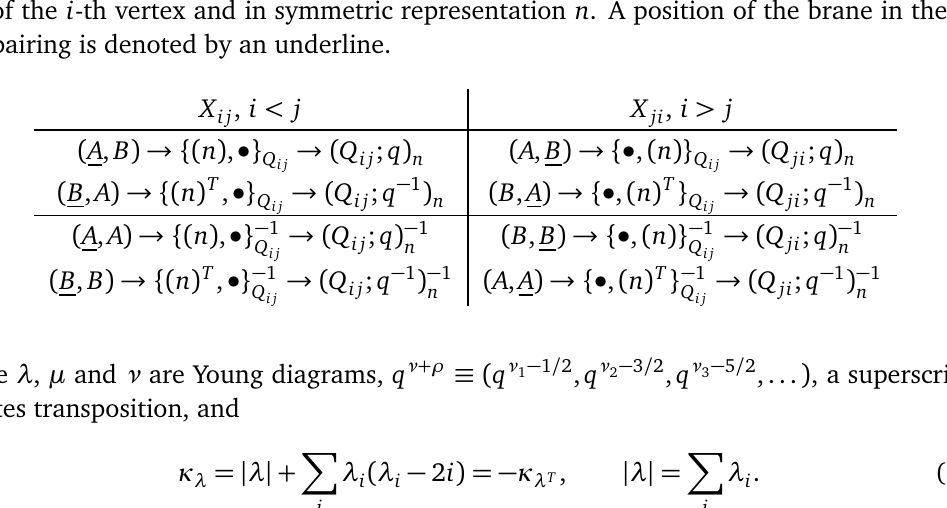
to the open string partition ij